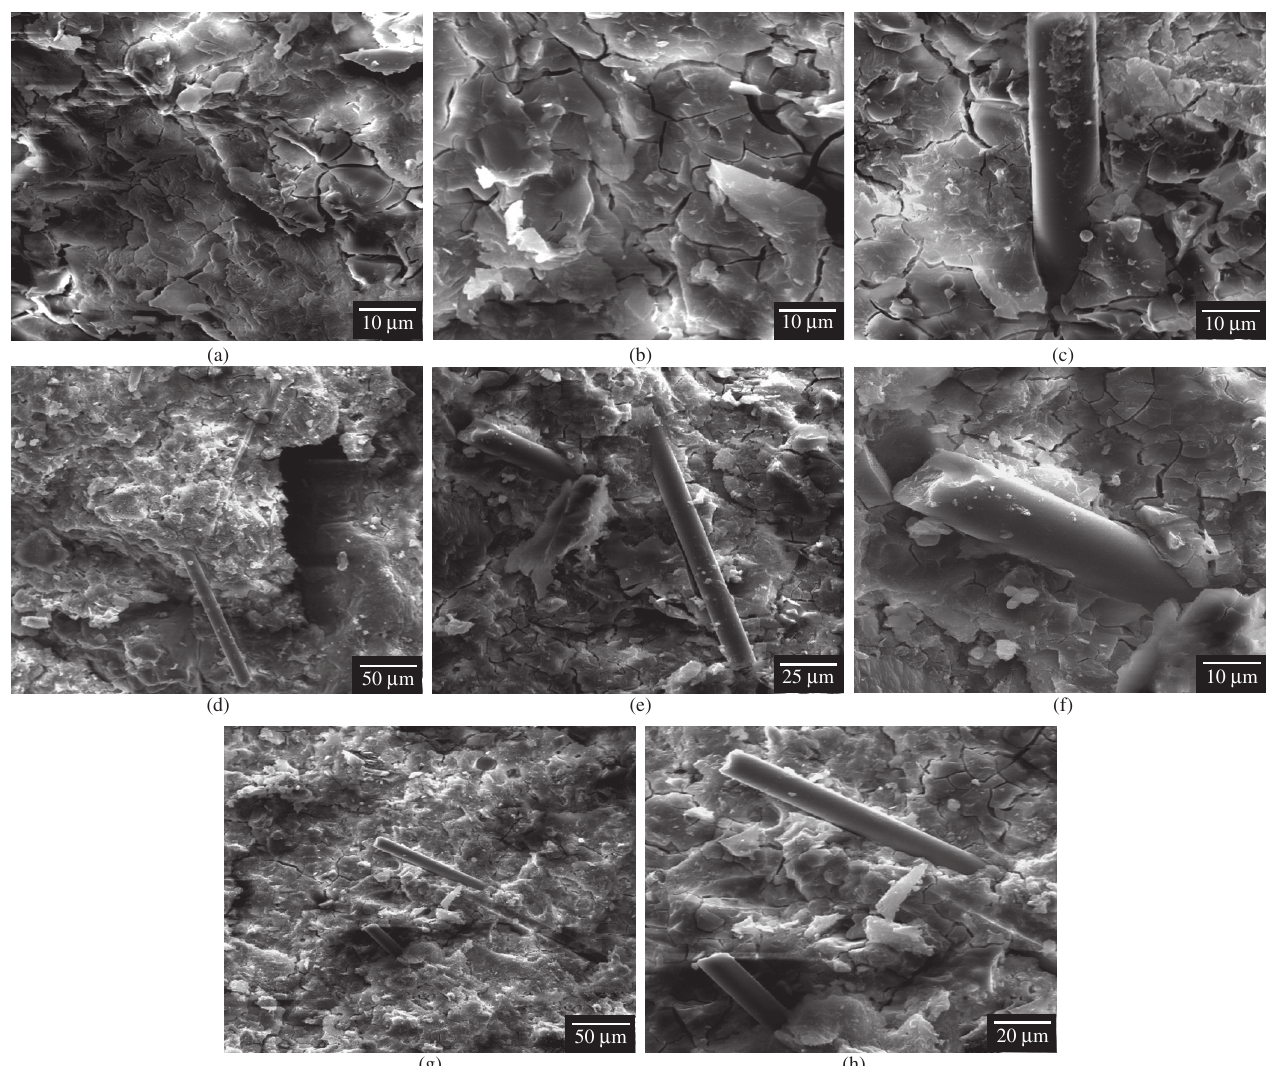
Figure 8. SEM micrographs of magnesium phosphate mortar with varying amounts of added grinding dust: a) and b) 0%; c) and d) 10%; e) and f) 20%; g) and h) 30%. Table 2. Capillary Absorption Coefficients (tan j ) of magnesium phosphate cement mortar as a function of sand and grinding dust contents and reliability (R 2 - correlation coefficient). Mortar mixture